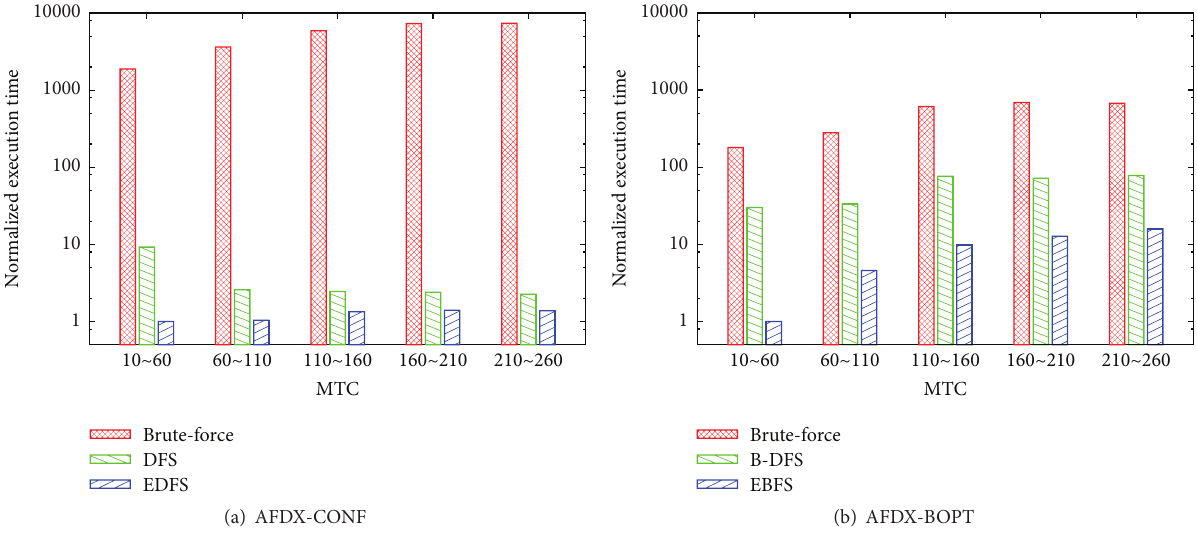
Figure 4: Normalized execution times of